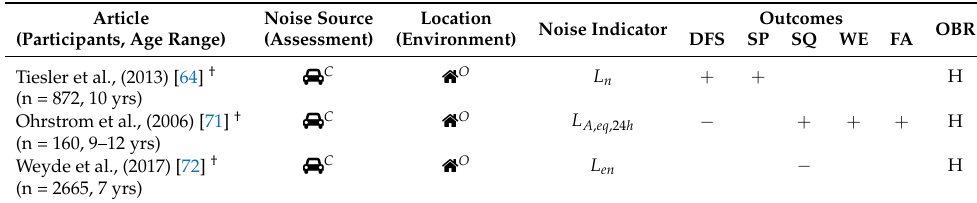
Table 11. Sleep-based studies. DFS corresponds to difficulties fall sleeping, SP to sleep problems, SQ to sleep quality, WE to waking episodes, and FA to feeling alertness. For explanation of symbols and notations, see the caption of Table 5. Article Noise Source Location Outcomes Noise Indicator OBR (Participants, Age Range) (Assessment) (Environment) DFS SP SQ WE FA ) C (cid:153) O L n + + Tiesler et al., (2013) [64] † (n = 872, 10 yrs)